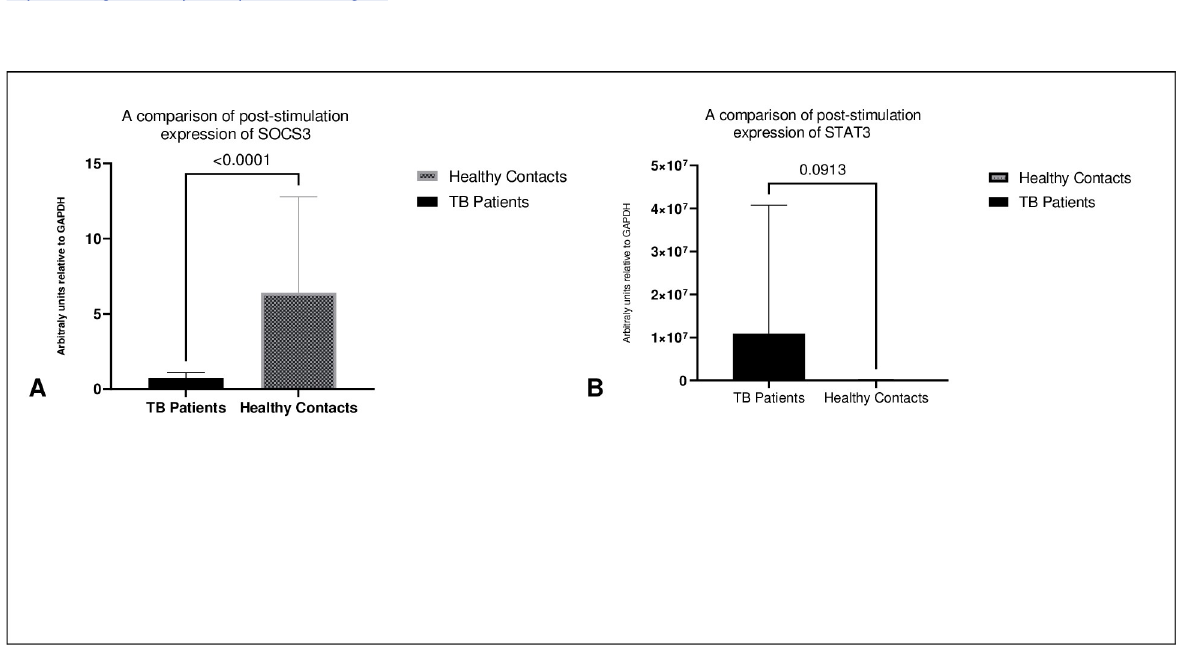
Fig 3. A : Shows significantly higher expression of SOCS3 in healthy contacts than TB patients post-stimulation. Median (IQR) 0.75 (0.175–1.8) in TB patients vs 6.4 (1.65–21.95) in healthy contacts, p value = < 0.0001. B : Shows no statistically difference in expression of in TB patients vs 93234 (966,847–118,833) in healthy contacts, p value = 0.0913. Statistical significance was evaluated using Mann–Whitney test.